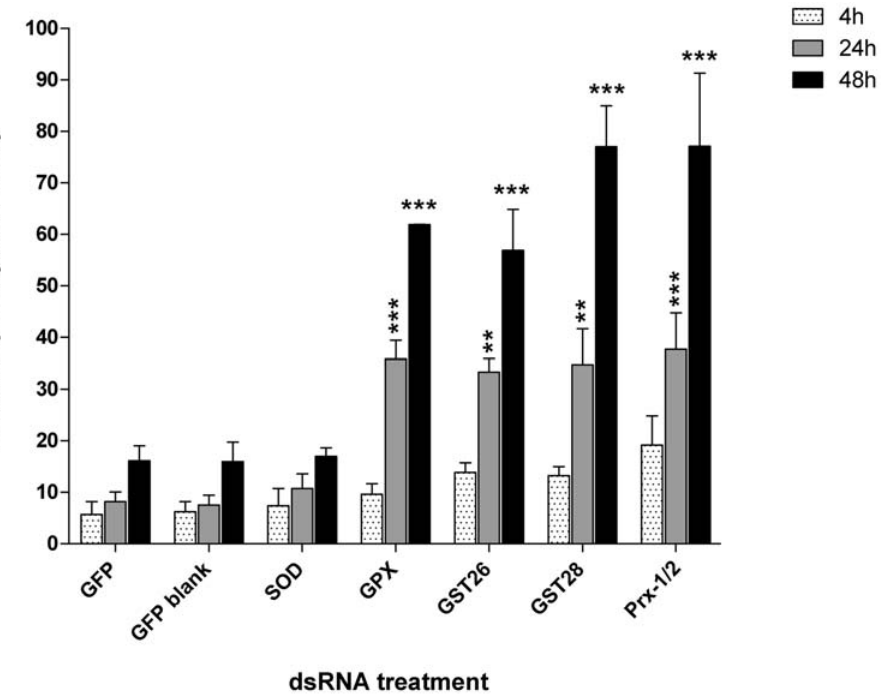
Figure 3. Graphic representation of the effect of exogenous H 2 O 2 exposure on Schistosomamansoni sporocysts following treatment with dsRNAs for GFP (specificity control), SOD, GPx, GST26, GST28 and Prx1/2. Double-stranded RNA-reated sporocysts were exposed to 50 m M H 2 O 2 for 4, 24 and 48 hrs (stippled, grey and black bars, respectively). Knockdown of larval GPx, GST26, GST28 and Prx1/2 antioxidants increased sporocyst mortality after 24 and 48 hr under oxidative stress conditions when compared to GFP dsRNA-treated or no treatment controls. Note that sporocysts treated with SOD dsRNA showed no difference in susceptibility to H 2 O 2 oxidation at any of the time points compared to controls. ** P , 0.001; *** P , 0.0001; N=4. doi:10.1371/journal.pntd.0000550.g003 Figure 4. Effects of catalase on H 2 O 2 -mediate killing of GPx, GST26, GST28, SOD, Prx1/2 dsRNA-treated and control GFP dsRNA- treated Schistosomamansoni sporocyst invitro . After 7 days of dsRNA incubation sporocysts were exposed to H 2 O 2 alone, catalase alone or catalase combined with H 2 O 2 for 48 hr followed by evaluation of sporocyst death using propidium iodide staining. Significant increases in H 2 O 2 – mediated mortality was abrogated in the presence of bovine catalase [H 2 O 2 + catalase] showing that H 2 O 2 was the primary source of larval killing in antioxidant dsRNA-treated sporocysts, with the exception of SOD, * P , 0.05; ** P , 0.001; *** P , 0.0001; N=6.